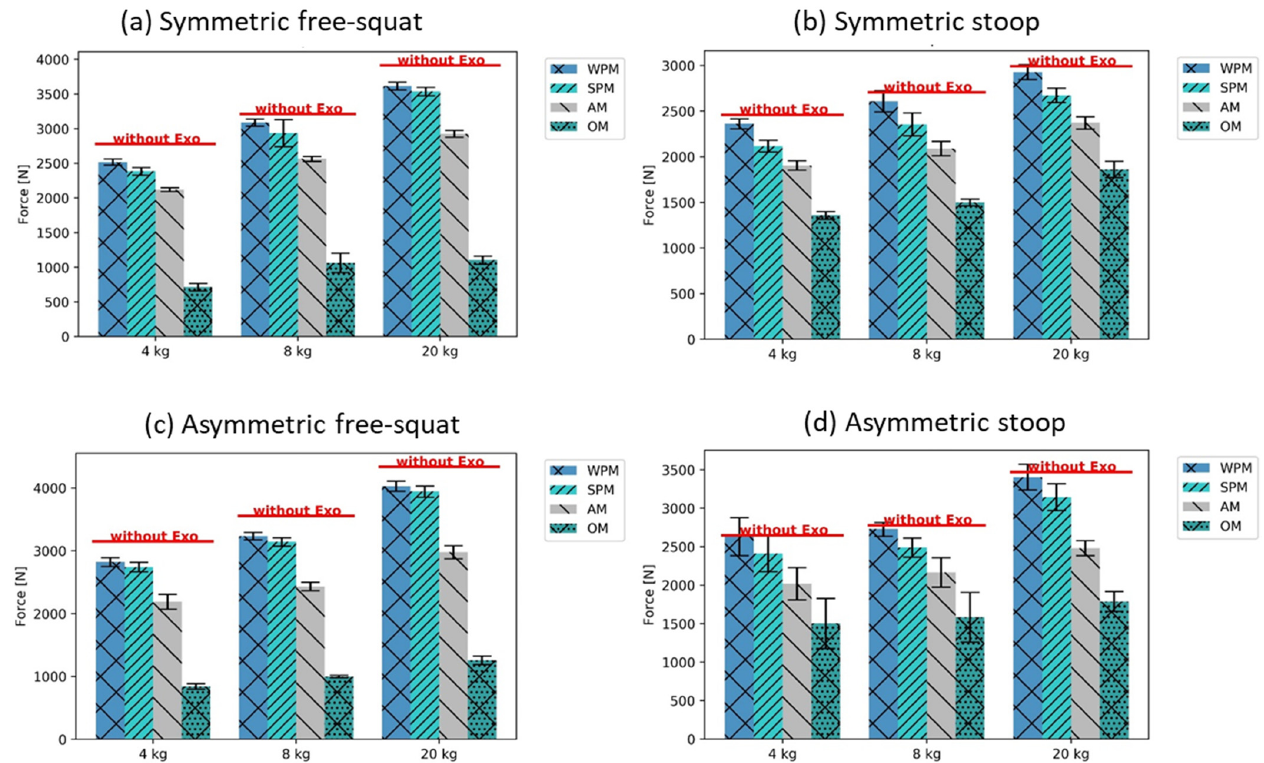
Figure 8. L4/L5 peak compression forces with the different exoskeleton support modes (±SD), compared to the reference as mean without exoskeleton support.